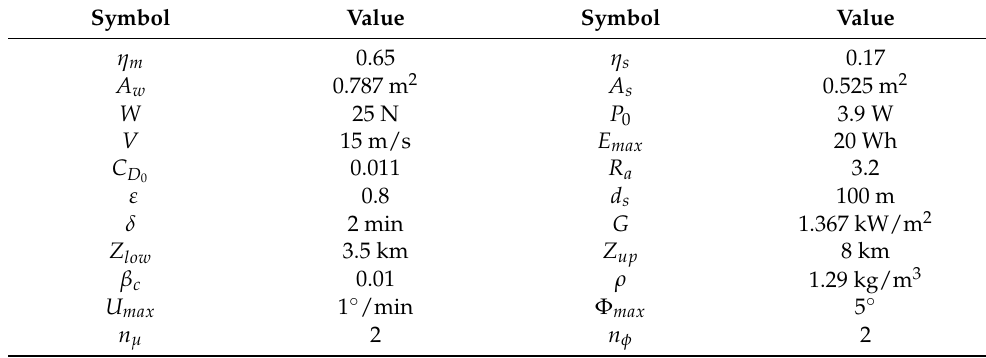
Table 2. Parameters used in